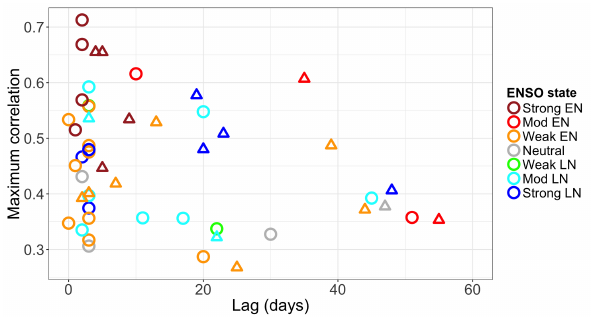
Figure 4. Results of lagged regression of FRB-averaged daily rain- fall, characterized by the current rainfall index (CRI), on stream- flow at Fraser-Hope. Only the subset of years wherein there exists a significant relationship between CRI and discharge are shown. The ENSO state, as specified in the legend according to colour (EN: El Niño, LN: La Niña), corresponds to the year preceding the rainfall and discharge, and was obtained from http://ggweather. com/enso/oni.htm, based on the same definition used in the analysis of Sect. 3 (i.e., NINO3.4). The maximum correlation, max( ˆ ρ XY ), is shown on the vertical axis, with the corresponding lag, τ , be- tween rainfall and discharge on the horizontal axis. A positive lag means that streamflow lags CRI. Circles: observed precipitation ver- sus observed discharge over the 1950–2006 period. Triangles: ob- served precipitation versus VIC-simulated discharge. All correla- tions are significant at the p < 0.05 level. Two outlier points with lags > 60 days (with none exceeding max( ˆ ρ XY ) = 0.42) are omit- ted from the